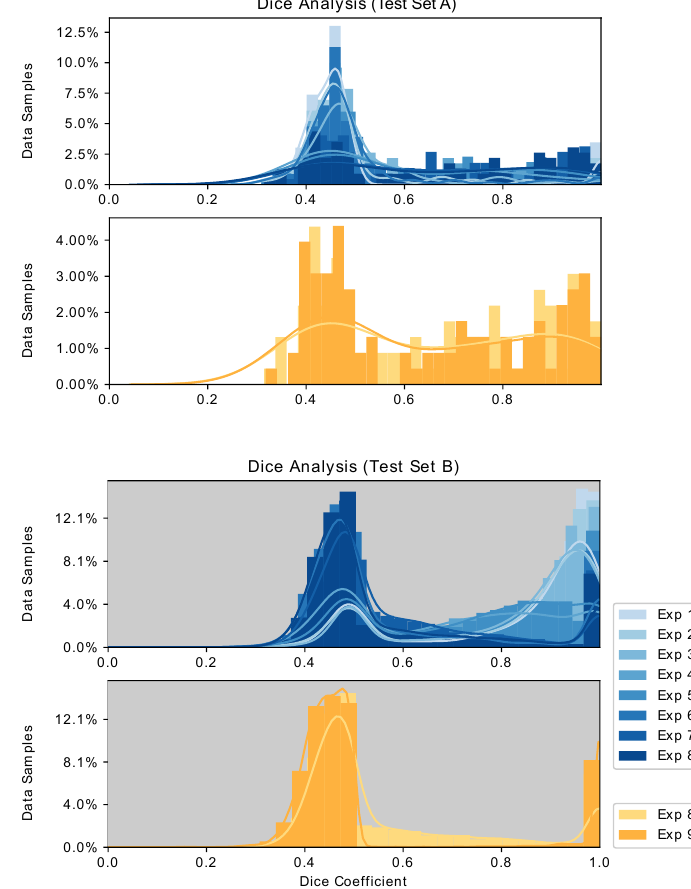
Figure 8. Histograms and distribution curves of the Dice coefficients of Exp. 1–8 and Exp. 8,9 evaluated on Test Set A and Test Set B